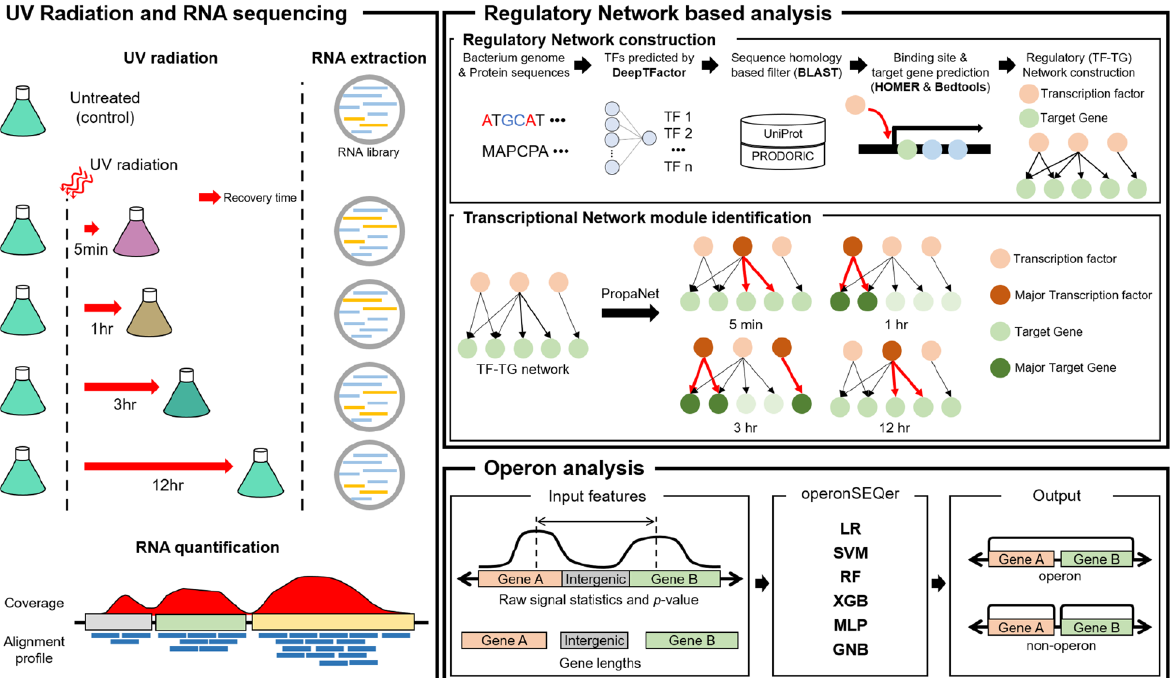
T was constructed using four T